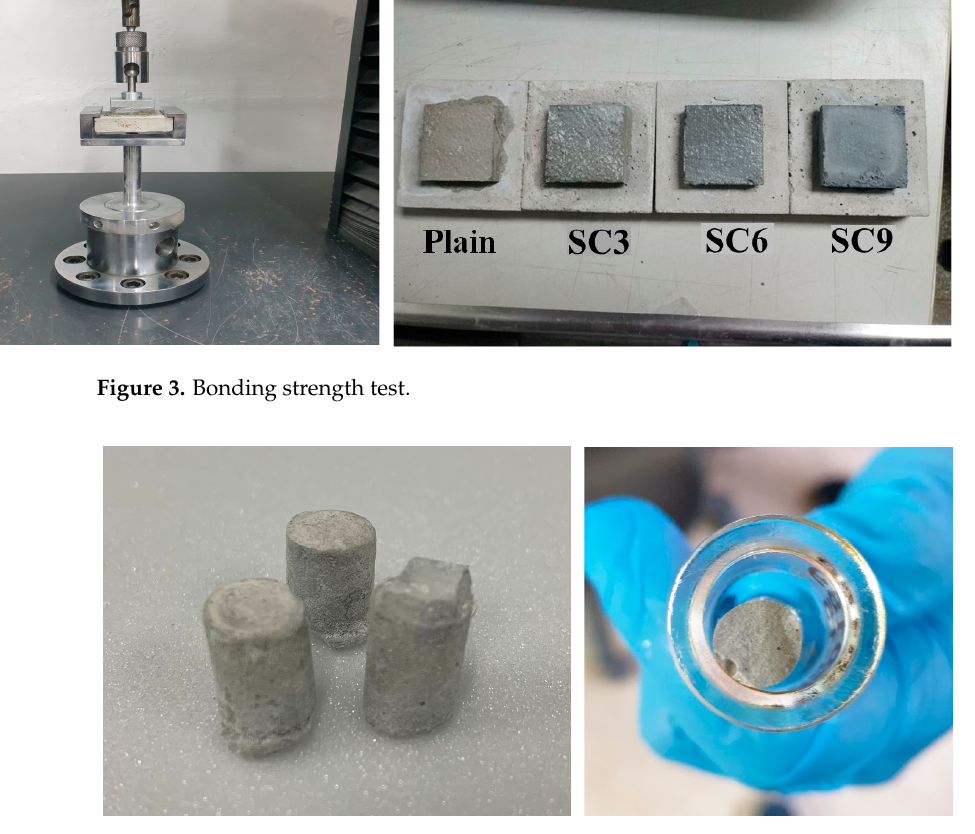
Figure 4. Sample of repair cementitous composite for porosity.